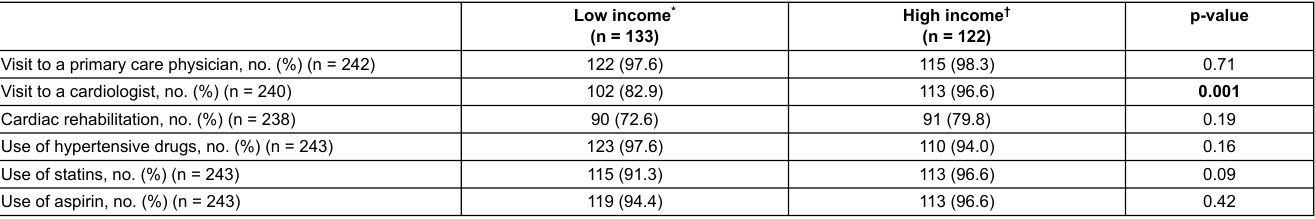
Table 3: Quality of care measured one year after discharge, by household income